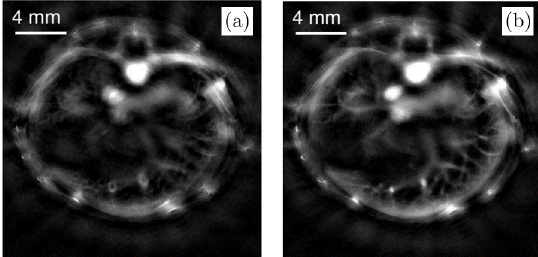
Fig. 8. Parameterized joint reconstruction. Initial pressure distributions reconstructed with a constant SOS of 1500 m/s (a) and the SOS distribution obtained by parameterized joint reconstruction (b). Reproduced with permission from Ref.